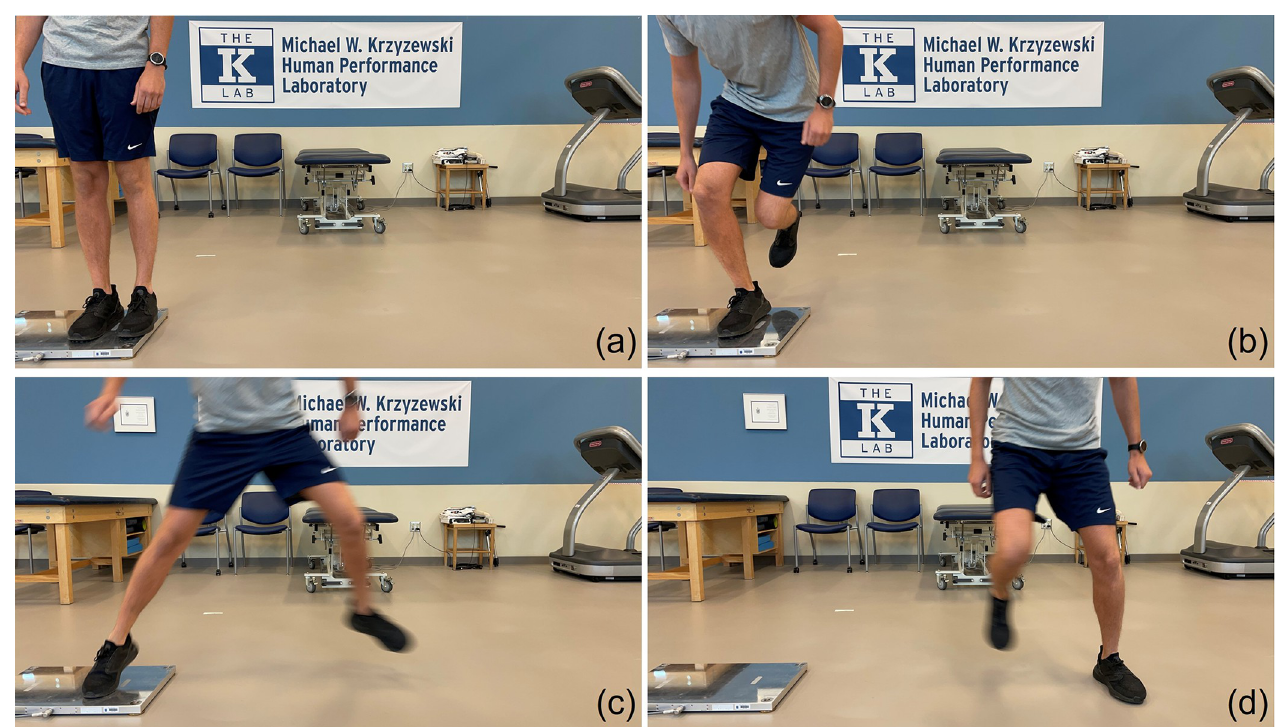
Fig 1. Lateral jump task protocol. Images represent (a) start point on force plate, (b) lift opposite leg, (c) takeoff on planted leg, (d) land on opposite